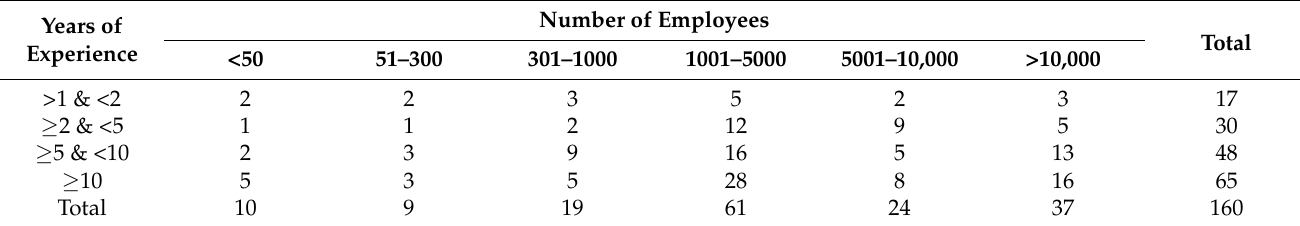
Table 2. Years of experience and number of employees. Table 3. Latent variable